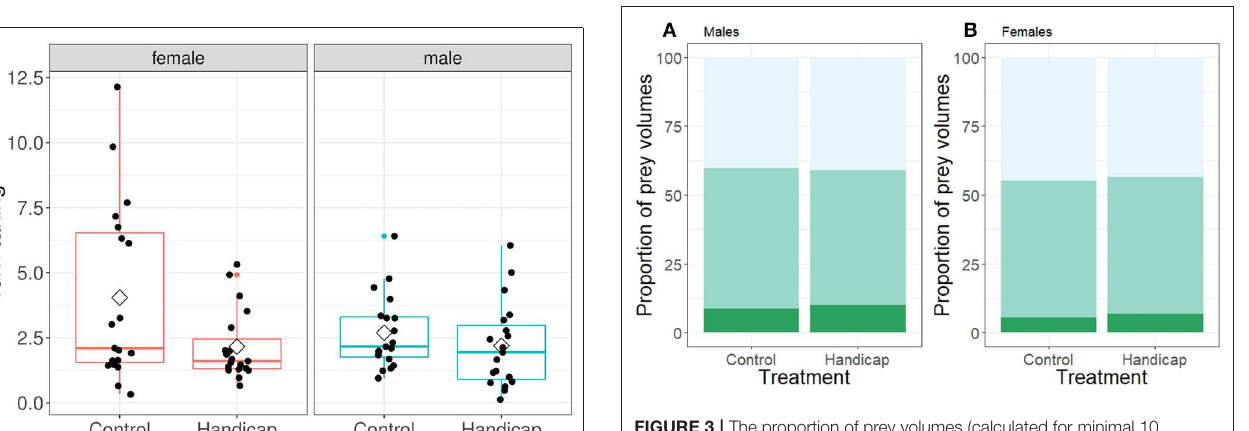
FIGURE 3 | The proportion of prey volumes (calculated for minimal 10 visits/individual) of (A) males and (B) females separated according to treatment (handicap n = 22, control n = 21). Light green bars (top bars) indicate the proportions of small prey items, medium green (middle bars) the medium prey proportions and the dark green (lowest bars) the proportions of the large prey items. Boxplot distribution with mean (diamond) and data points are